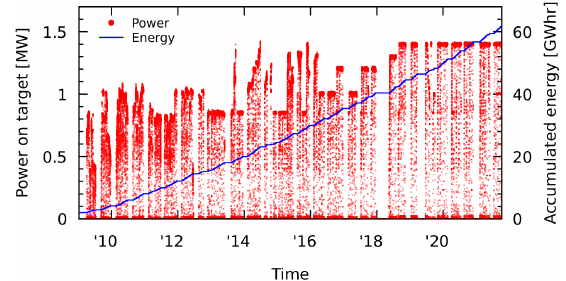
FIG. 3. Time evolution of the accumulated energy (right-hand side vertical axis) and instant power on the target (left-hand side vertical